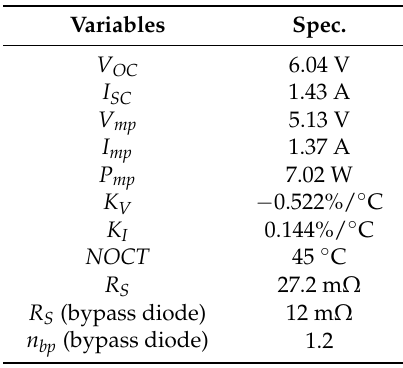
Table 1. Parameters of the experimental modules.